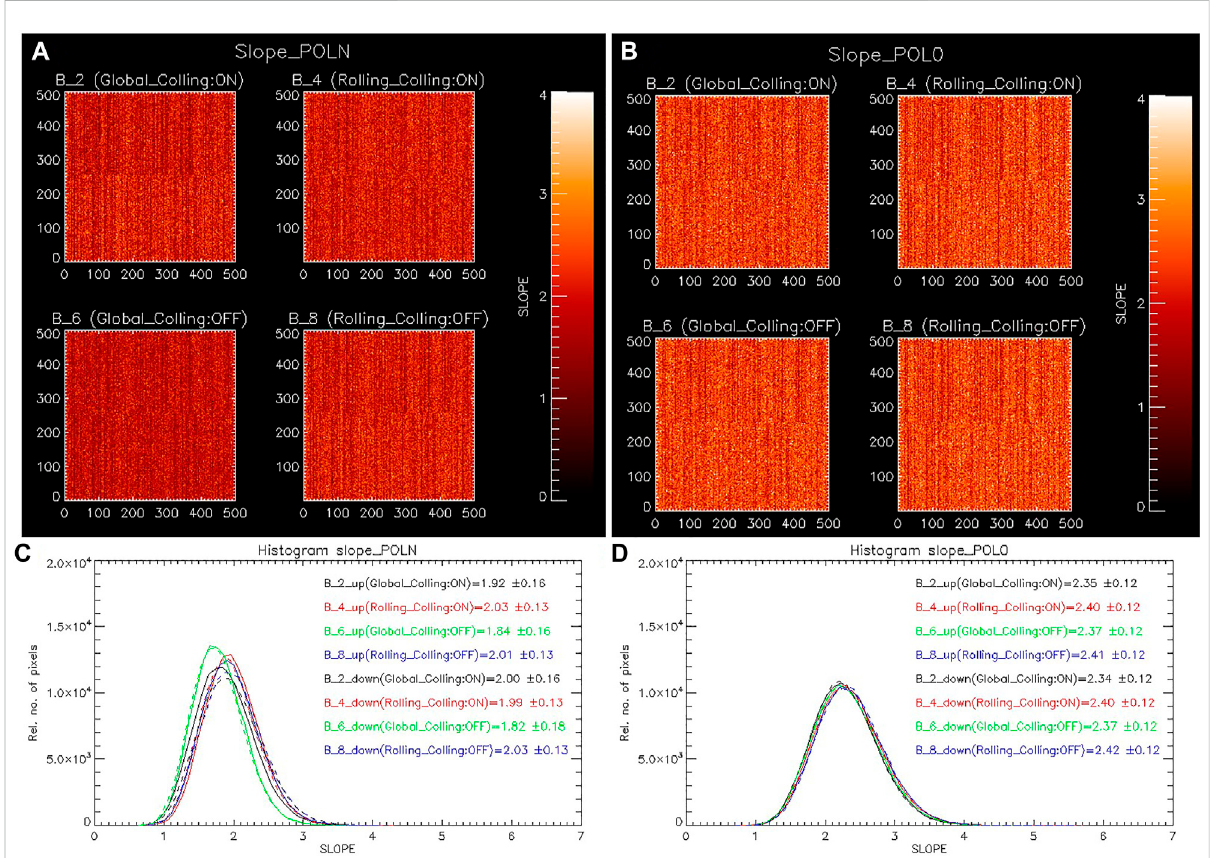
FIGURE 7 2D plot of the gain per pixel for each block of the (A) POLN (without the reference polarizer) and (B) POL0 (with the reference polarizer at 90 ° ). Blocks2and6arefromGlobalShutterandblocks4and8arefromRollingShutter.B2andB4havethecoolingON,whileB6andB8havethecooling OFF. Panel (C,D) show the POLN and POL0 data histograms, respectively. The data here is split between the two halves of the sensor. The solid line represents the top (up) of the sensor, and the dashed line the bottom